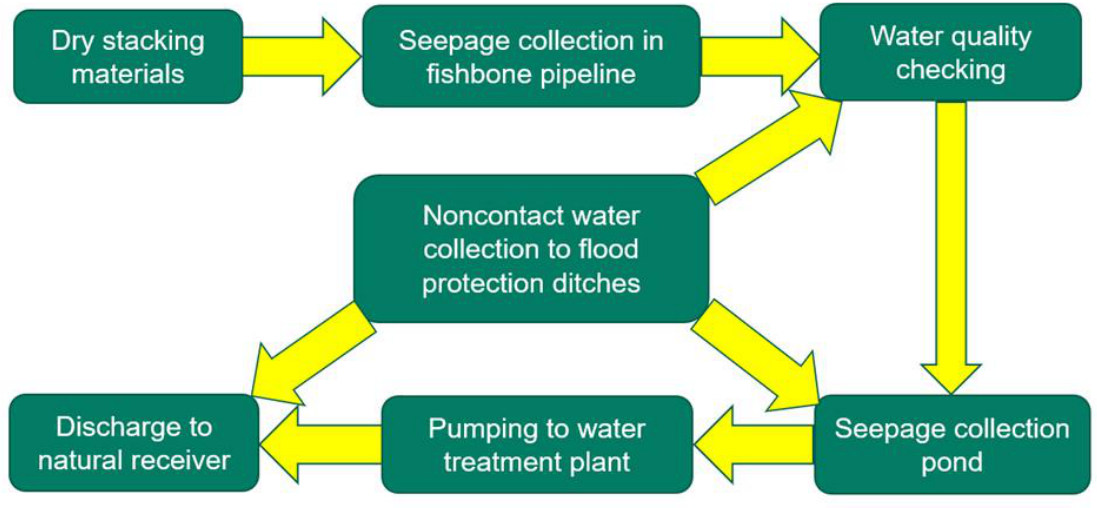
Figure 4. Kokkinolakas TMF water management